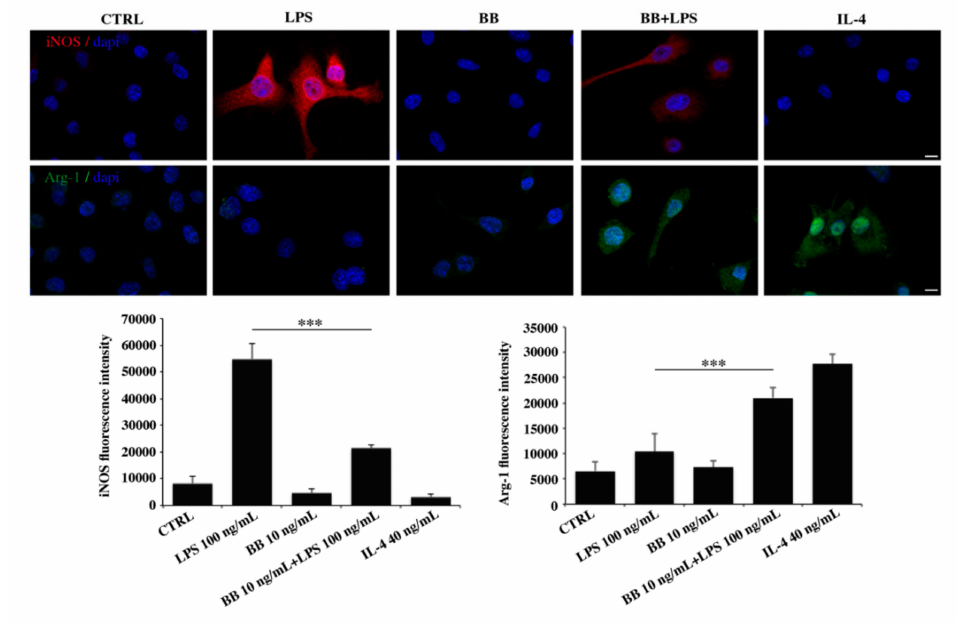
Figure 6. Immunofluorescence analysis of M1 / M2 polarization markers. Cells were treated with 10 ng / mL BB in the absence or presence of 100 ng / mL LPS and stained for iNOS and Arg-1. IL-4 was used as positive control for Arg-1. Bar: 20 µ m. Fluorescence intensity was quantified with Image J software. Results from three independent experiments are presented as mean ± SD. *** p < 0.001 compared to